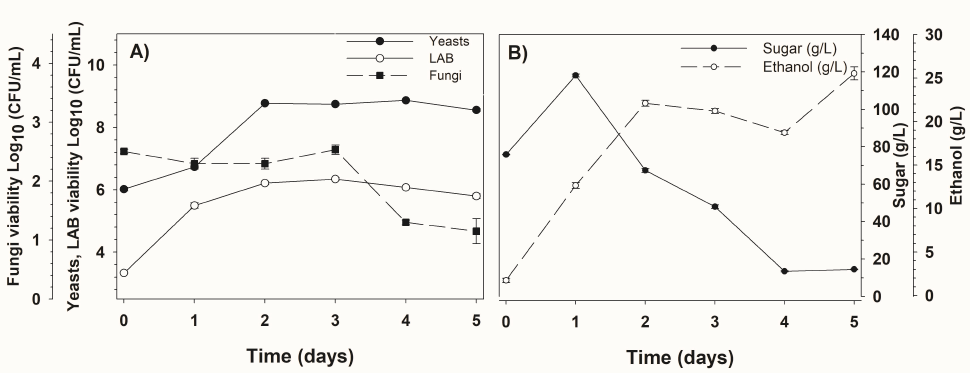
Figure 1. The evolution of principal microorganisms, sugar, and ethanol concentration during the fermentation of sotol ( Dasylirion sp.) must. ( A ) Viability of filamentous fungi ( ■ ), total yeasts ( ● ), and lactic acid bacteria (LAB) ( ○ ). ( B ) Pro fi les of sugar ( ● ) and ethanol production ( ○ ).